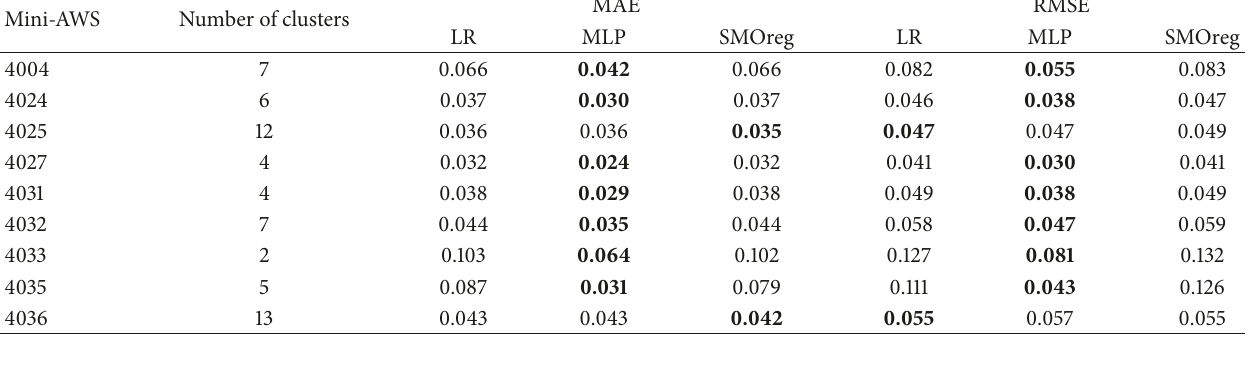
Table 6: Experimental results for clustered Mini-AWS data.